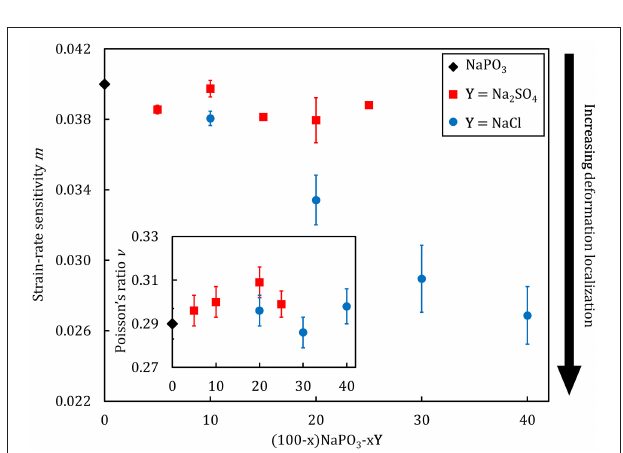
FIGURE 5 | Strain-rate sensitivity as a function of composition for (100–x)NaPO 3 -x Y (with Y = Na 2 SO 4 , NaCl) glasses. The inset displays the compositional dependence of the Poisson’s ratio.